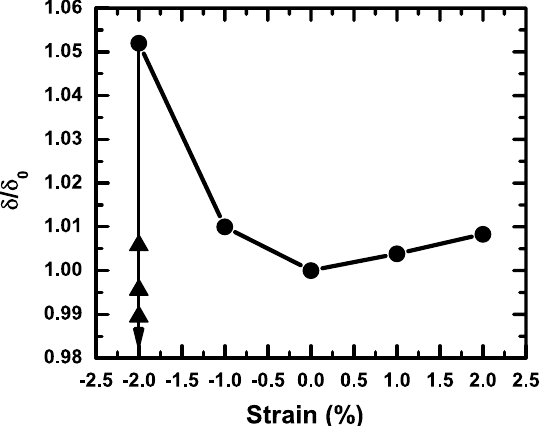
Figure 8. The variation of off-centre displacement ( δ ), normalized by the value ( δ 0 ) for strain-free sample, with lattice strain (circles) as obtained from first principle calculations; the results obtained under compressive pressures in presence of large lattice strain are also shown